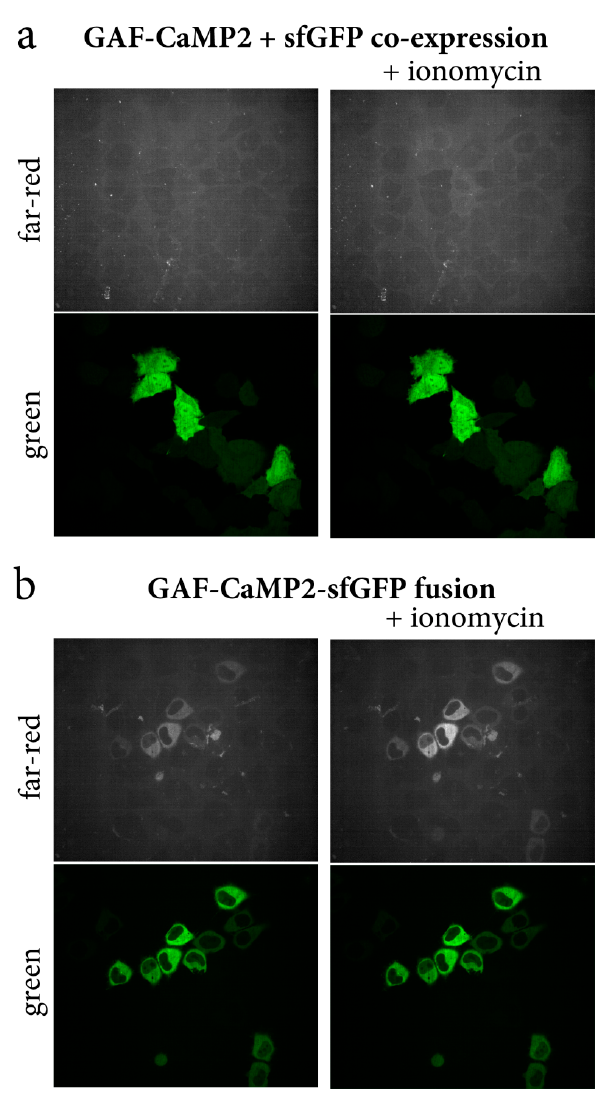
169% ± 56% to the ionomycin-induced calcium concentration elevation. 18